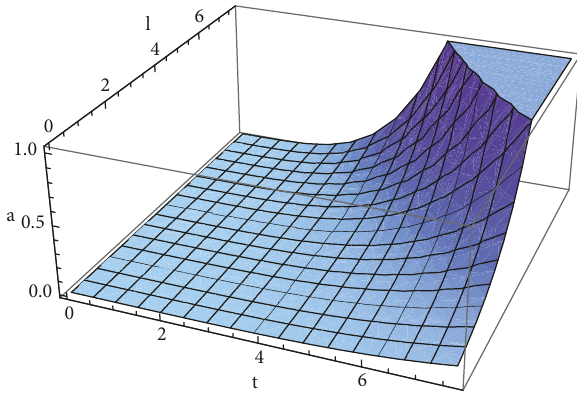
Figure 3: Case II: 𝑎 as a function of 𝑡 and 𝑙 for 𝛼 2 = 1 and 𝜅 = 0.537 .